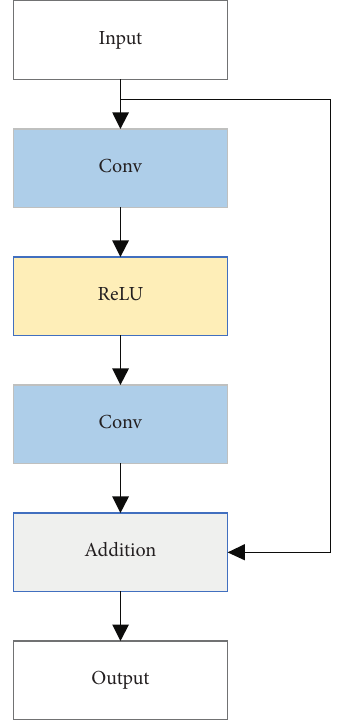
Figure 3: The ResBlocks with no IN and BN layers are not introduced.